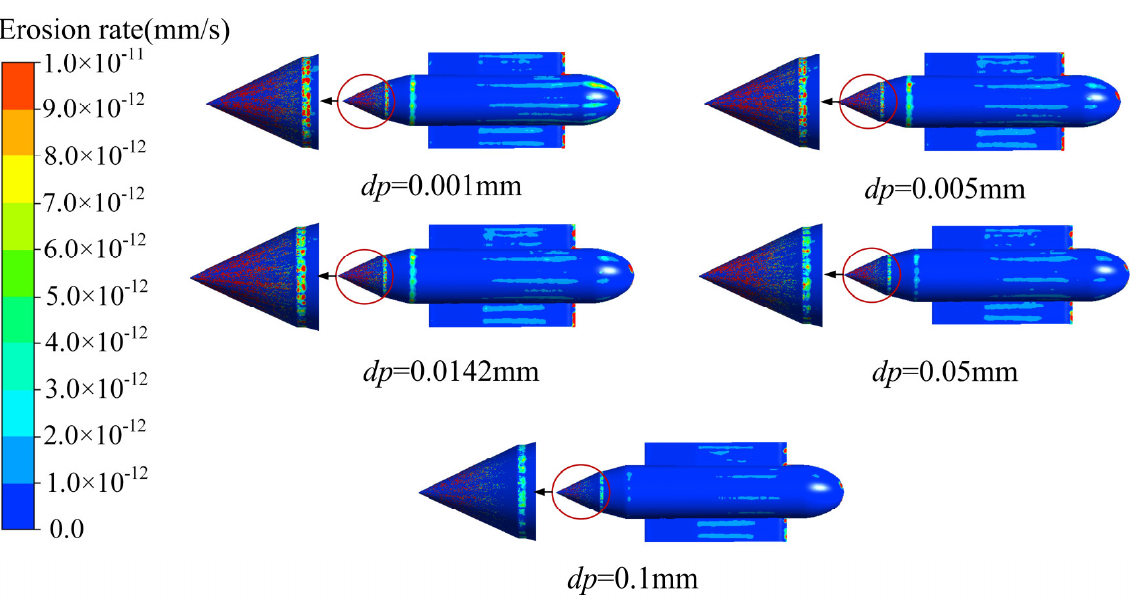
Figure 8. Erosion patterns of needles with different sediment particle